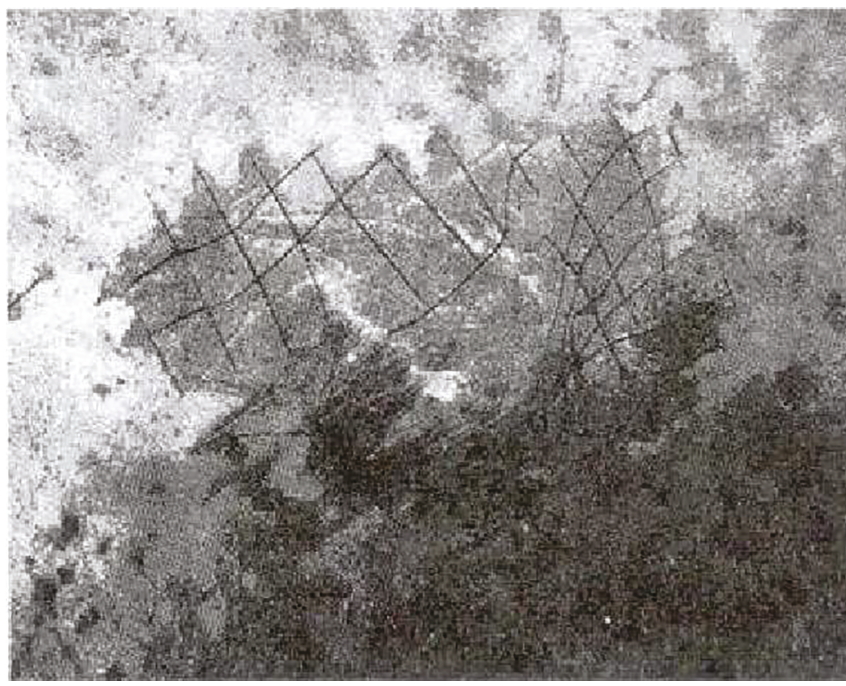
Figure 5: Rockburst site after shotcrete support. Table 2: Original data in three tunnel sections at the Jiangbian hydropower station.